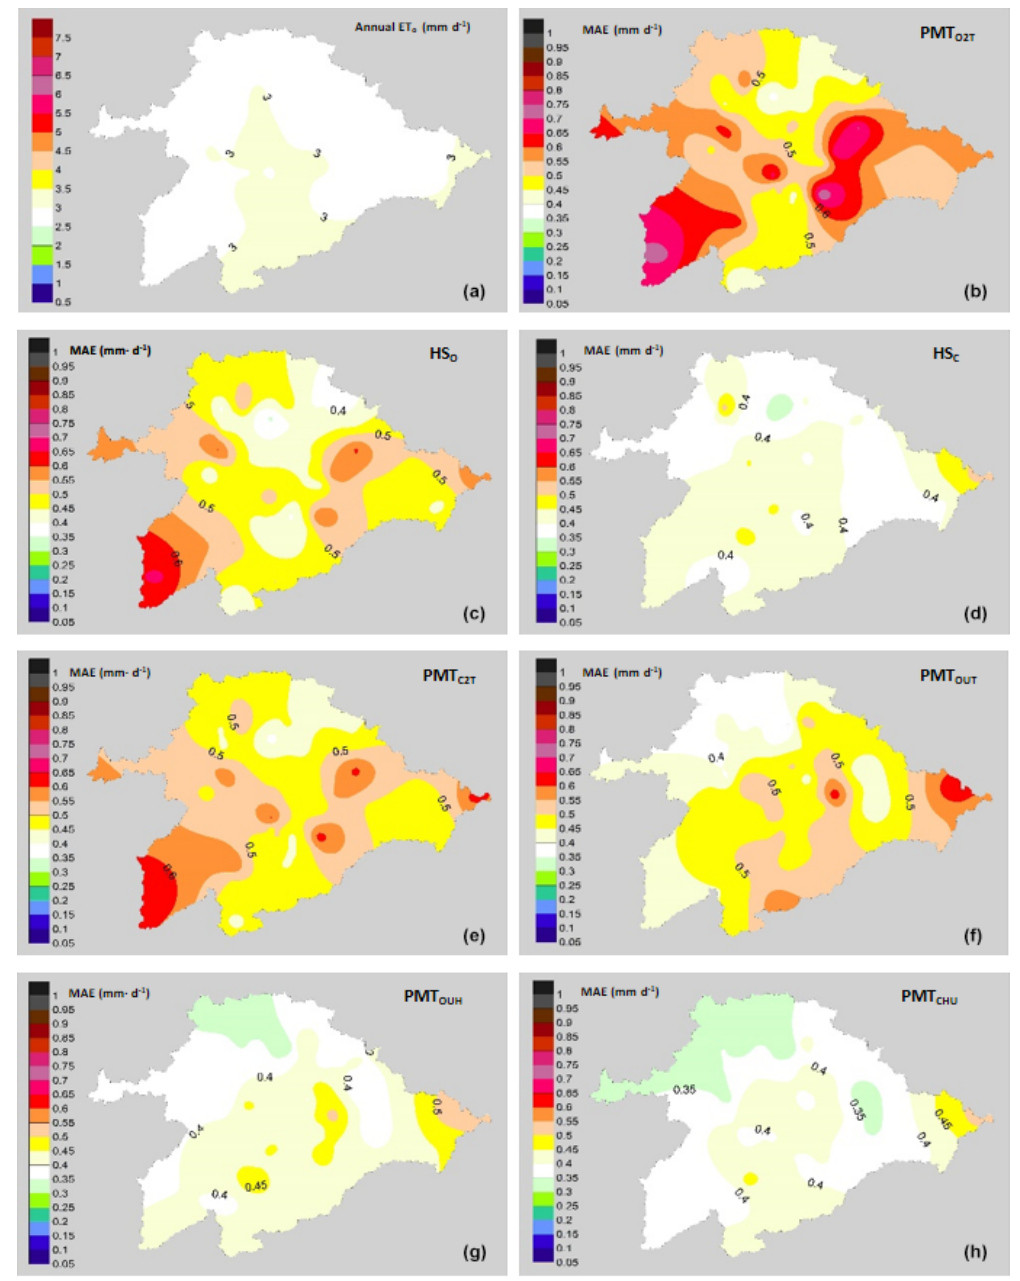
Figure 3. Performance of the models with an annual focus. (a) Average annual values of ET o (mmd − 1 ). Mean values of MAE (mmd − 1